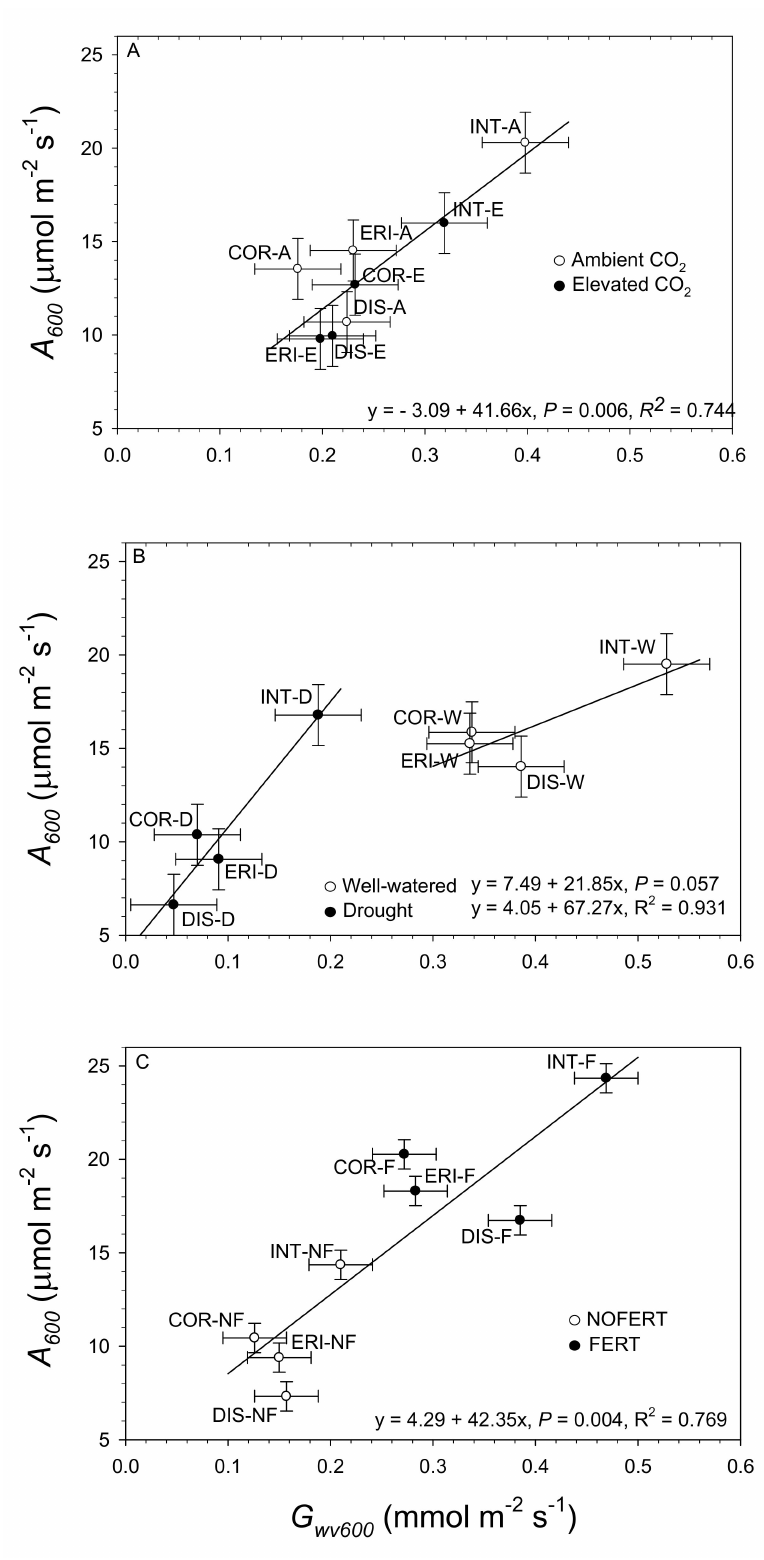
Figure 6. Relationship between assimilation at 600 ppm ( A 600 ) and stomatal conductance at 600 ppm ( G wv600 ) across four willow species under ( A ) ambient and elevated CO 2 treatments, 2017, ( B ) well- watered and drought treatments, 2017, and ( C ) non fertilized and fertilized treatments,